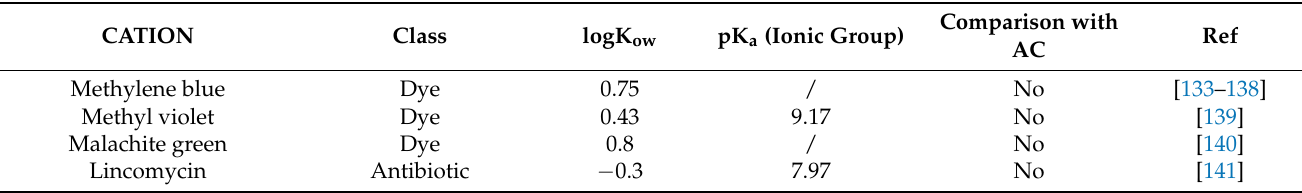
Table 3. List of the most investigated organic pollutants removed by biochars in the last ten years’ worth of literature. Compounds are grouped following their ionizable properties. The values of their logK ow and pK a (if applicable), as calculated using Chemicalize Software [132], are